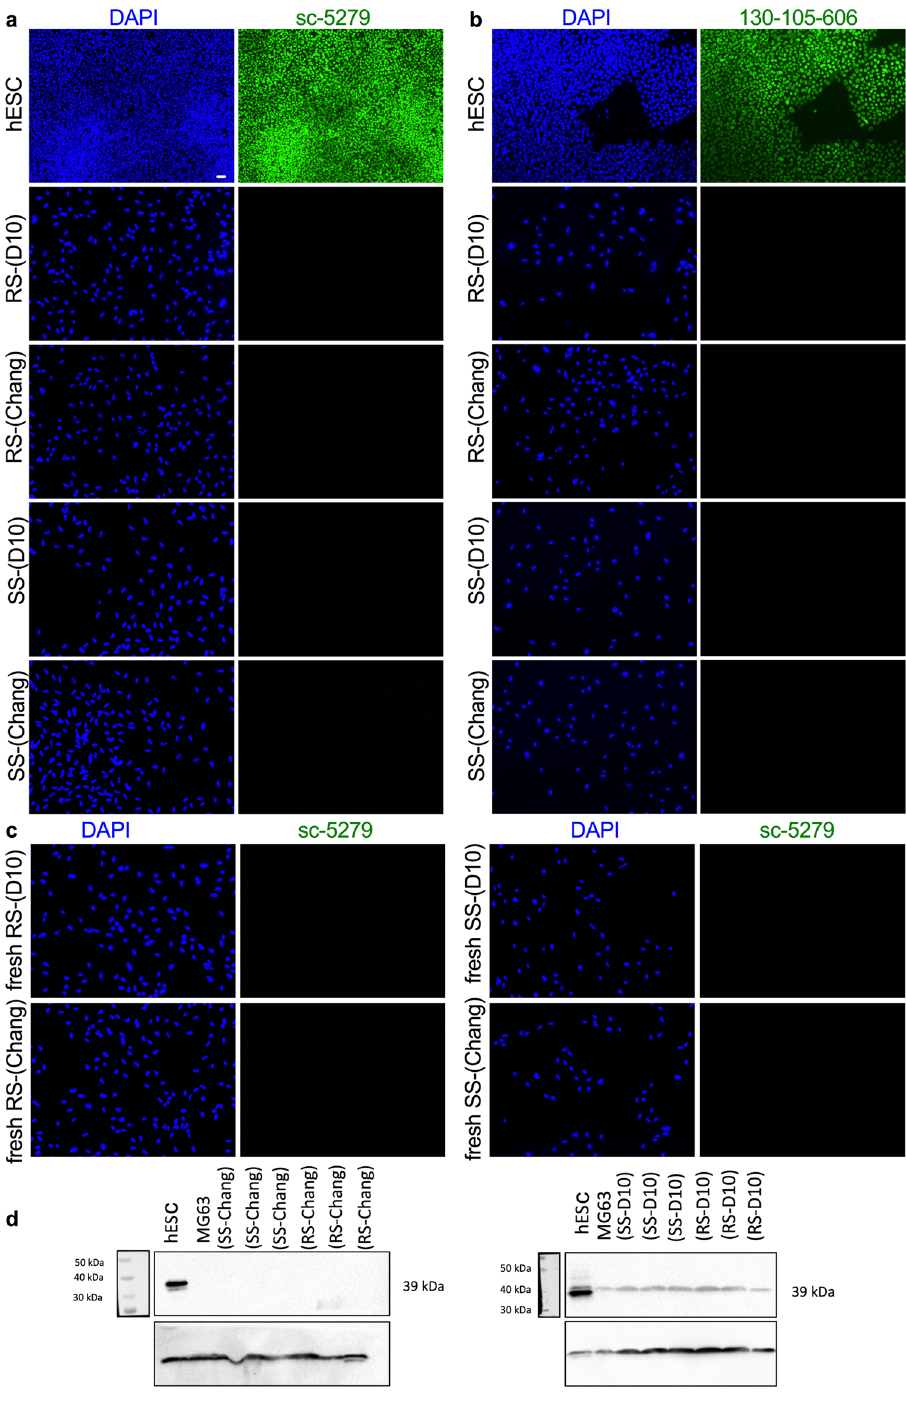
Figure 3. Expression of OCT4A in hAFSCs. Immunofluorescent cell staining showing expression of OCT4A using the antibodies sc-5279 ( a ) and 130-105-606 antibody ( b ) in hESCs (positive control) and RS-hAFSCs and SS-hAFSCs cultivated in Chang C or D10 culture medium that have previously been expanded, frozen and thawed or in freshly-isolated cells that have not been expanded beyond passage 1 and never frozen ( c ) (40X magnification). Nuclei were stained with DAPI (blue). Scale bar 50 μ m. ( d ) Western blotting for OCT4A detection in RS-hAFSCs and SS-hAFSCs cultivated in Chang C or D10 culture medium and in hESCs (positive control) and MG63 (negative control). Cell lysates were prepared and western blot was performed using sc-5279 antibody against OCT4A and antibody against β